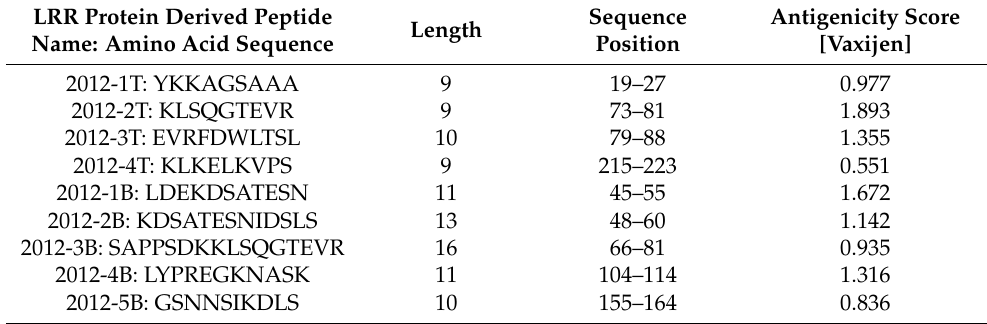
Table 3. The predicted antigenic epitopes of the rKU_Sej_LRR_2012M protein-derived peptides . LRR Protein Derived Peptide Name: